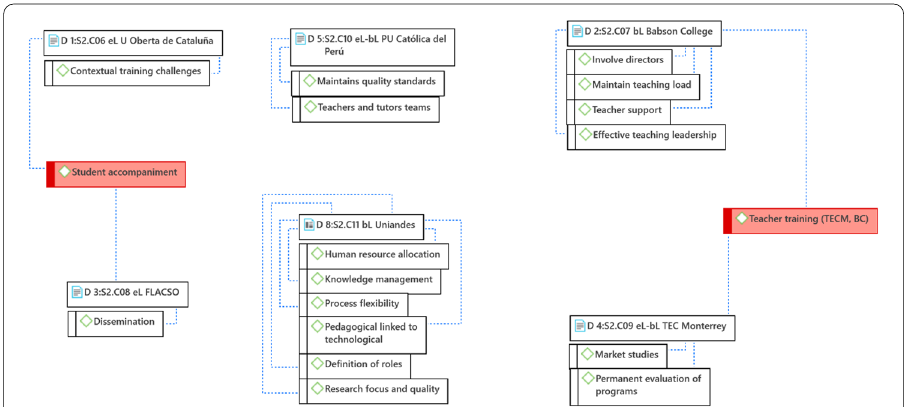
Fig. 10 Structure of driving ideas that entail key success factors for the organization. Source: Diógenes